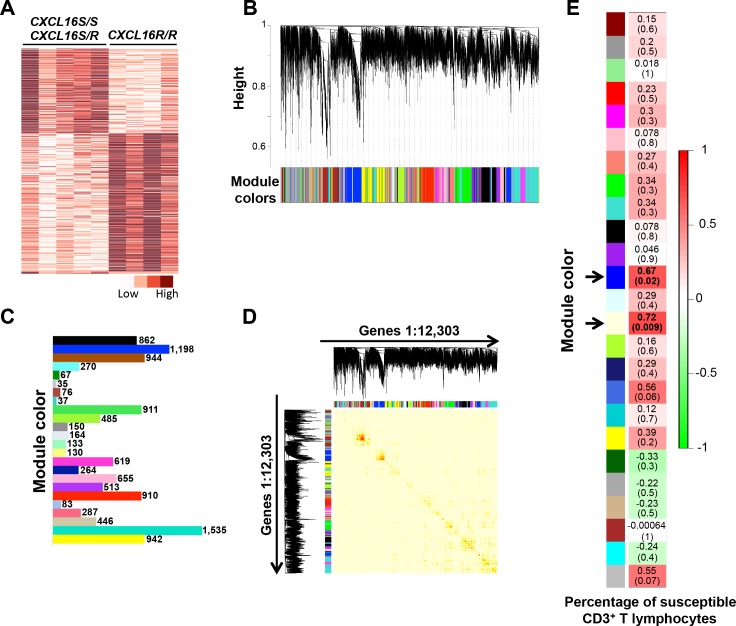
Differential gene expression and weighted gene co-expression network analysis in stallions homozygous and heterozygous for the CXCL16S allele (CXCL16S/CXCL16S and CXCL16S/CXCL16R; n = 5).(A) A total of 542 genes were differentially expressed between animals exhibiting different genotype (i.e. between stallions carrying the susceptibility allele [CXCL16S, n = 5] and those who did not [homozygous for CXCL16R, n = 4]) and following EAV infection. A lower proportion (188 genes) were upregulated in stallions carrying the CXCL16S allele. Darker reds are indicative of a higher expression. The interactive heatmap can be found herehttp://rpubs.com/pouyadini/379472. (B and C) Gene module identification as determined by weighted gene co-expression network analysis (WGCNA). A total of 24 gene modules with varying number of genes were identified among 12,303 selected genes. (D) Gene co-expression network construction for selected genes. The heatmap depicts the topological overlap (correlation between the expression profiles of each pair of genes). Each row and column correspond to a gene, where light color denotes low topological overlap with progressively darker color indicating higher topological overlap. Dark squares along the diagonal represent gene modules. (E) Module-trait correlation heatmap based on the correlation analysis of module eigengenes (MEs) and percentage of CD3+ T lymphocytes susceptible to in vitro EAV infection in stallions (n = 12). Pearson correlation values (r) are shown for each module along with the respective p-value within parenthesis. The blue and lightyellow modules (arrows) presented a significant positive correlation with CD3+ T lymphocyte susceptibility (p-values < 0.05).